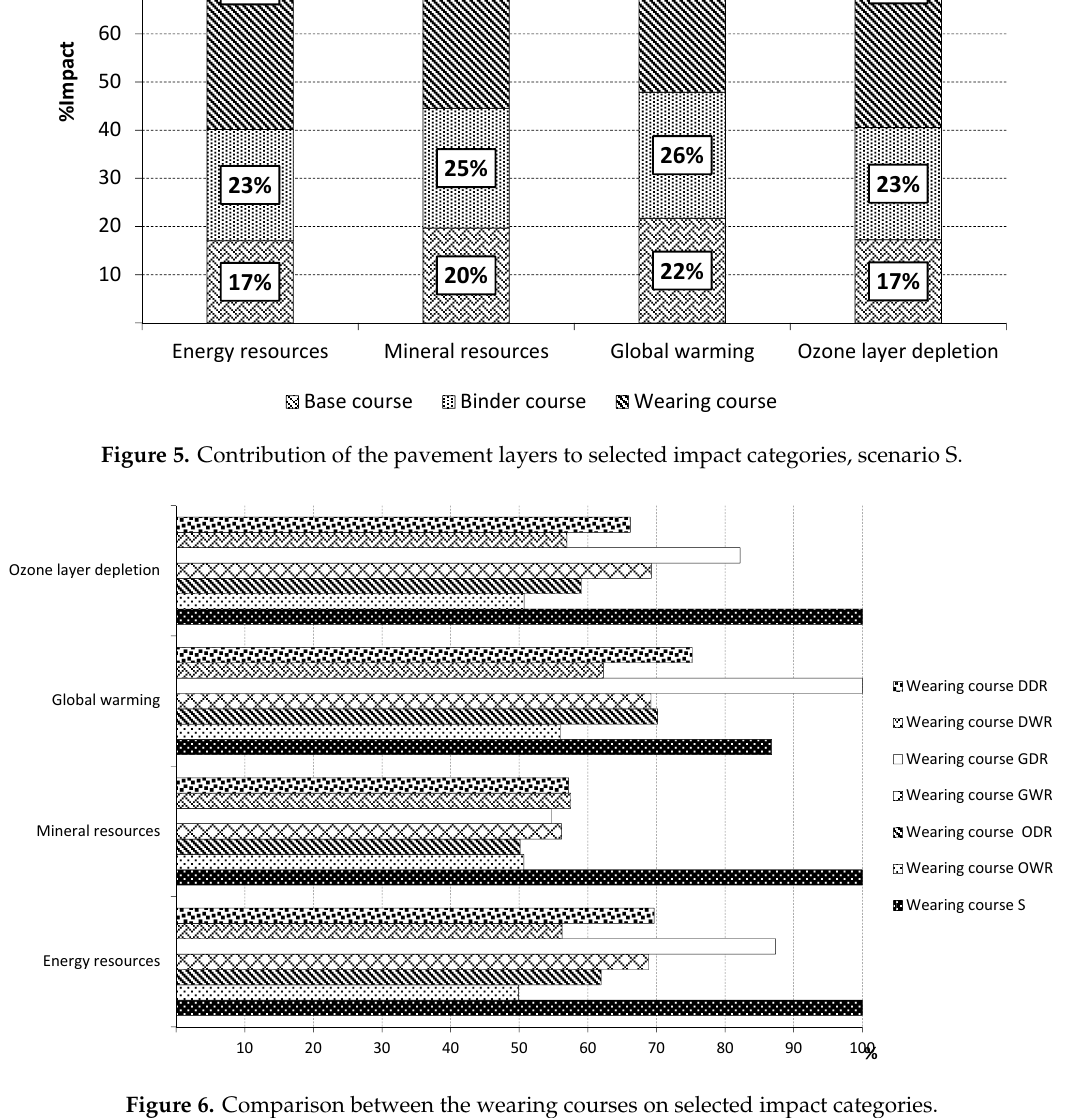
Figure 6. Comparison between the wearing courses on selected impact categories.